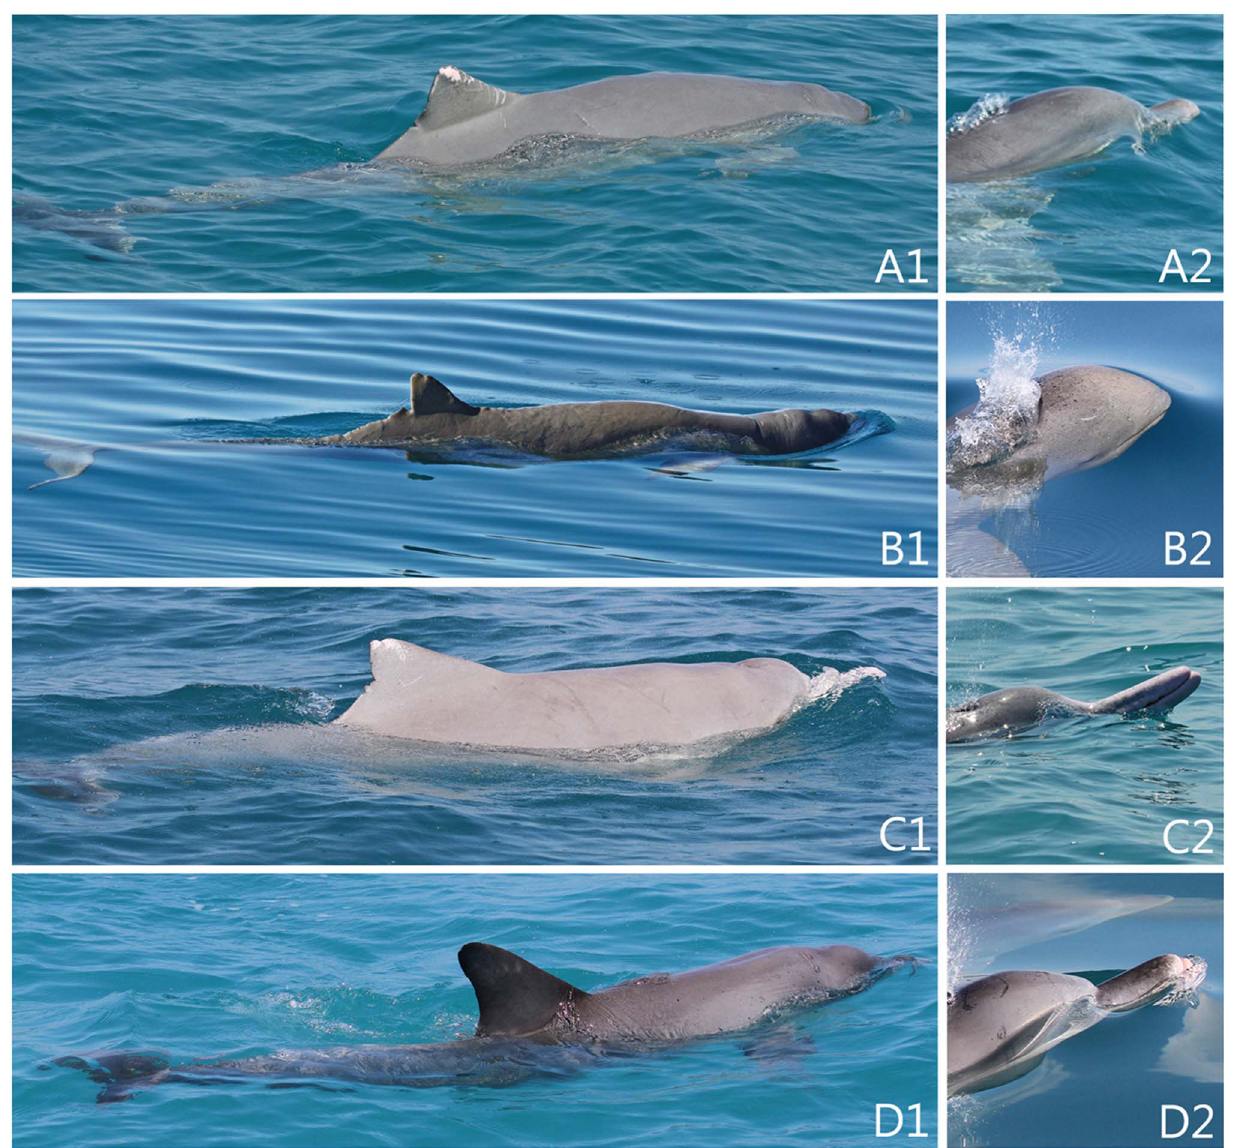
Figure 4. Images of hybrid (A1–2), adult snubfin (B1–2), humpback (D1–2) and bottlenose (D1–2) dolphins encountered at Cygnet Bay. Left images show relative dorsal proportions; right images compare head/rostrum characteristics. proportion of shading in individual bars in Figure 3D). The mtDNA haplotype of the suspected hybrid matched a haplotype found in snubfin dolphins (Figure S4), suggesting that she most likely had a snubfin dolphin mother. The STRUCTURE results and allele comparisons suggest a humpback dolphin father. From all samples included in this study, other than the hybrid, only one other, a male snubfin dolphin from Roebuck Bay, showed some signs of mixed species ancestry. Images of this individual suggest a normal snubfin dolphin phenotype. STRUC- TURE assigned this individual by 16.7% (10 iterations, SD= 0.00) to humpback dolphin (Figure S2) and 83.1% (0.00) to snubfin dolphin. This is suggestive of post-F1 hybrid status, although the small number of microsatellite markers used in this study restricts our interpretation of such results.